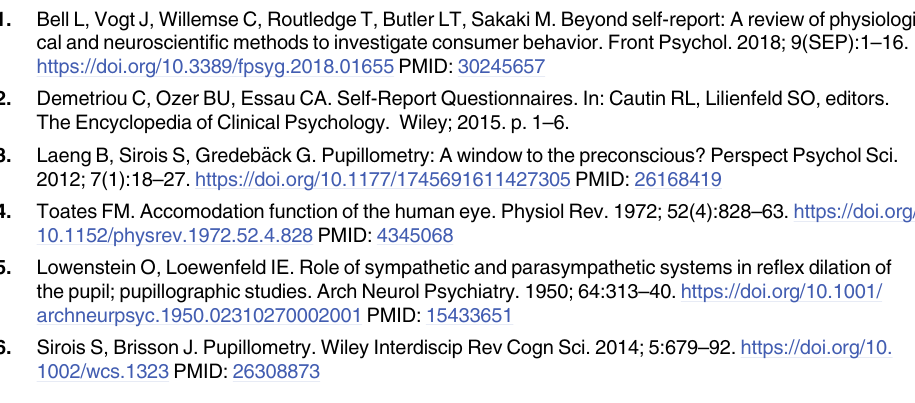
grey lines depict the individual mean baseline across all trials of this participant. Colorful solid lines illustrate the effective pupil size difference. Product categories are depicted as follows: Beverages (green), personal care (purple), cleaning (red), and food (orange). b) Fraction of participants showing an effect similar to the direction of the entire group for each product cat- egory. Results computed for each window. Dashed grey lines depict 50% of participant show- ing the same effect as the group. Color scheme as in panel a.